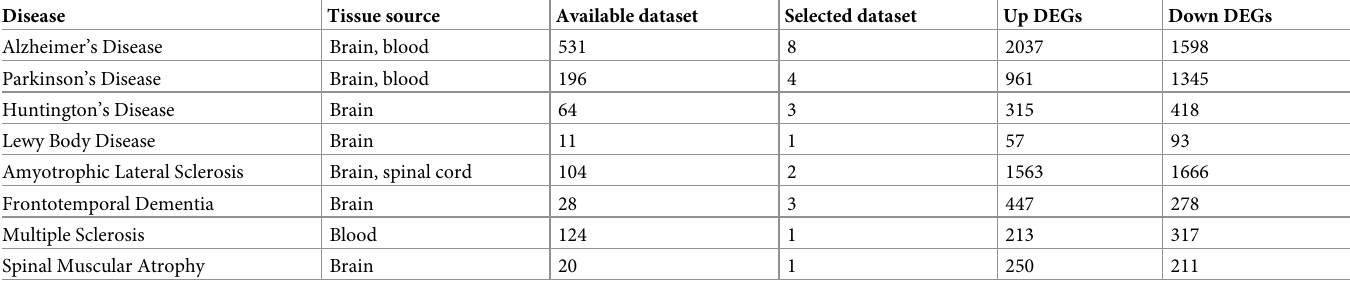
The 4th, 5th, 6th and 7th columns represent the number of unfiltered genes, the number of significant DEGs with threshold for p-value, adjusted p-value and logFC (numbers in brackets are for logFC with threshold 2) respectively. The 8th and 9th columns show the number of unfiltered GO terms and significant GO terms considering Fisher exact test.